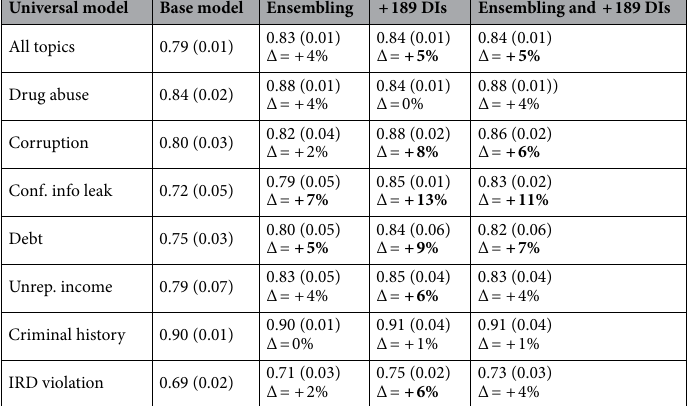
Table 8. The impact of ensebling and extra data on AUC. Significant values are in